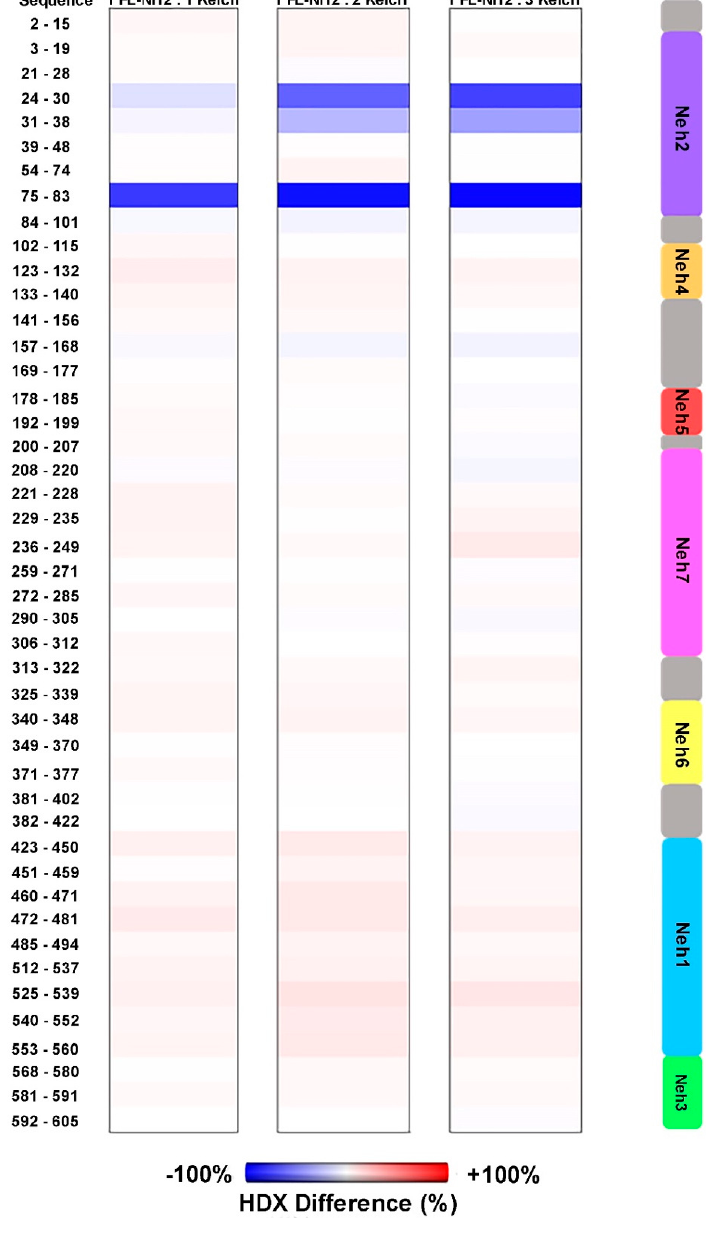
Figure 5. HDX-MS% difference plots of FL-Nrf2 upon addition of Kelch in 1:1, 1:2, and 1:3 ratios relative to free FL-Nrf2 at t = 6 s. Blue represents reduced deuteration, and red represents enhanced deuteration after the addition of Kelch. The side panel indicates the domain organization of FL-Nrf2.